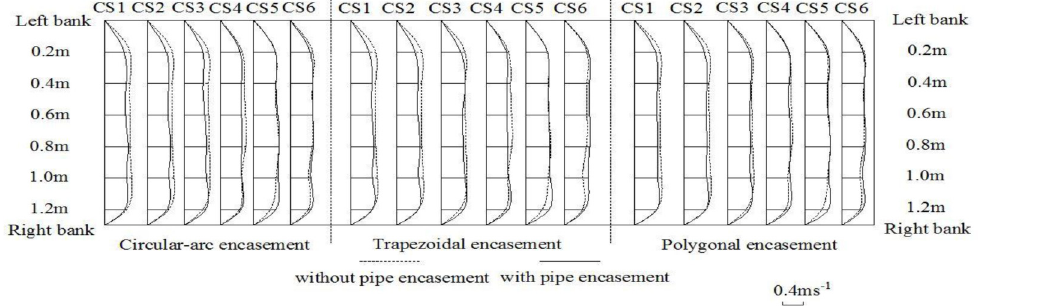
Fig 12. Distributions of flow speeds at CS1-CS6 for a 50-year flood